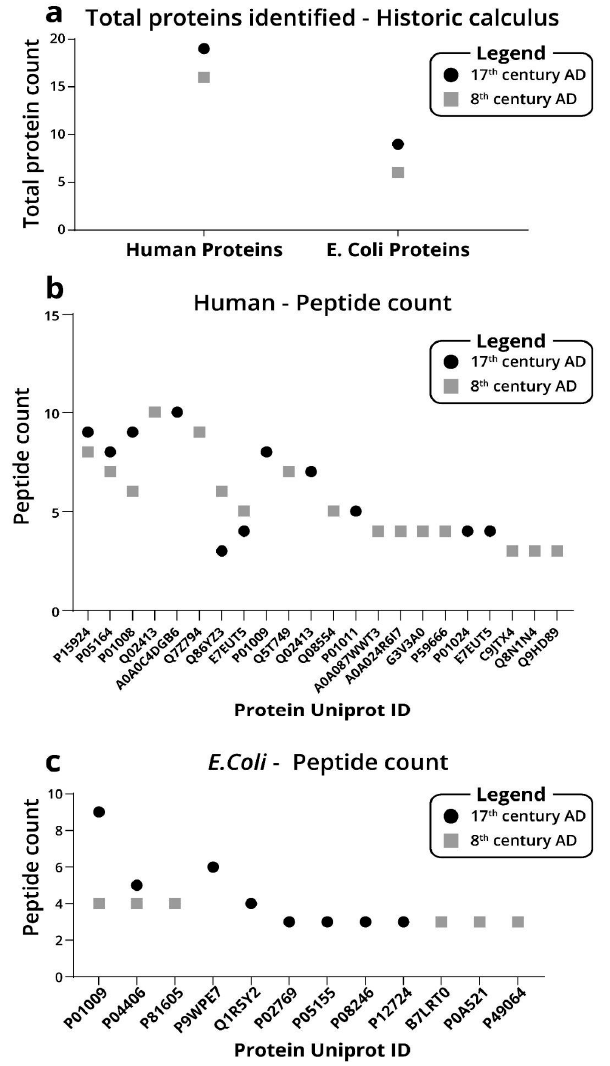
Figure 5. Number of peptides identified for each protein identified by 2 h MS run. ( a ) protein count of human proteins from historic dental calculus. ( b ) Peptide count of human proteins from historic dental calculus. ( c ) Peptide count of E. Coli proteins from historic dental